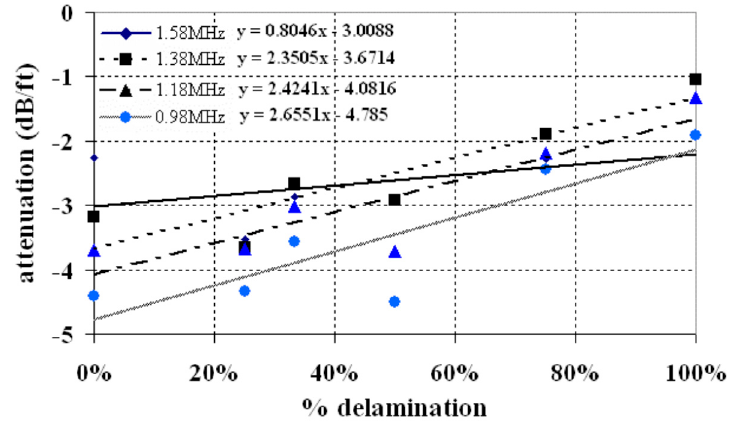
Figure 23. The attenuation versus the delamination percentage [68].